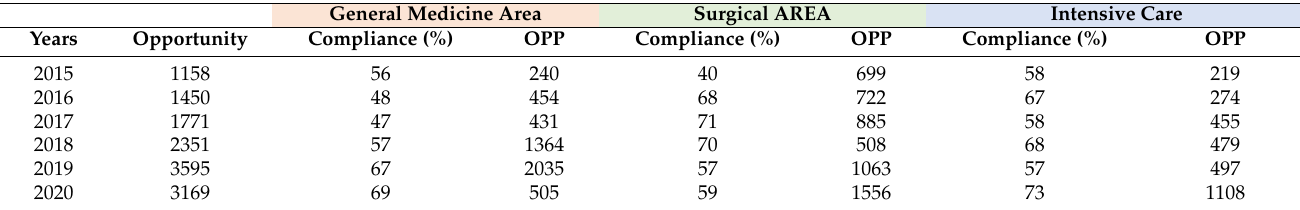
Table 3. Adherence to hand hygiene by areas, per years.